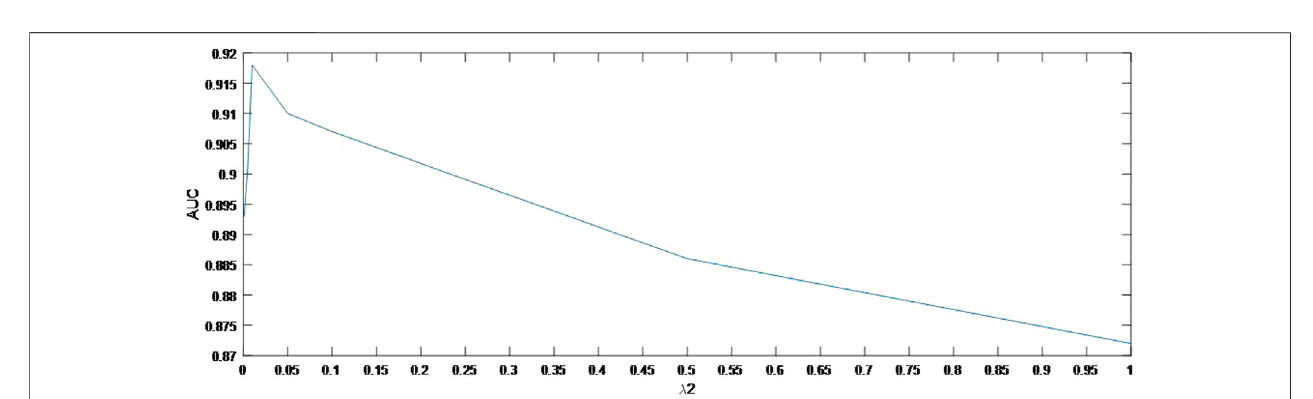
FIGURE 4 | Variation of the AUCs with the various settings of λ 1 .